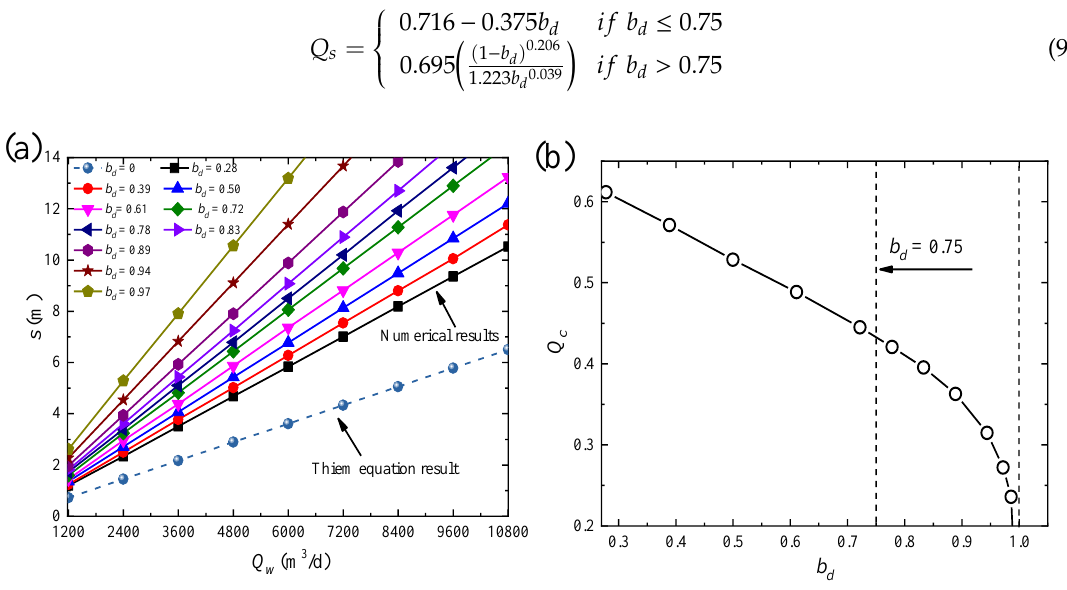
ff erent b d ; ( b ) standard